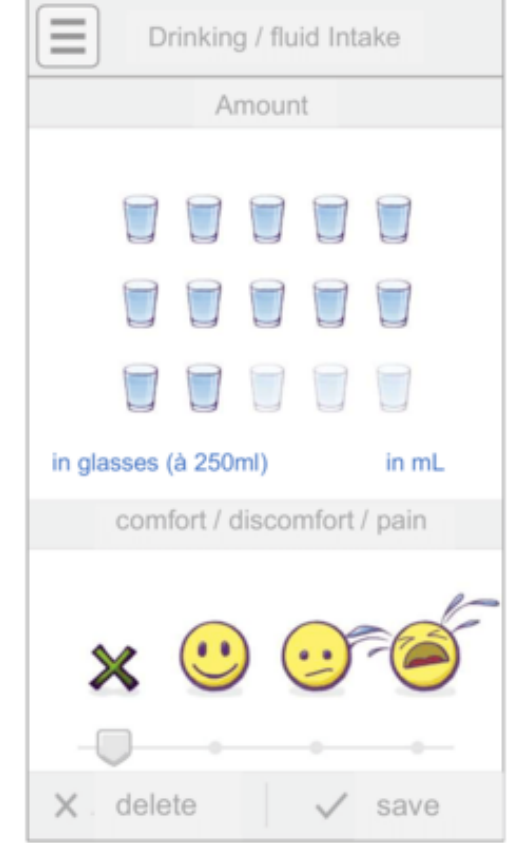
Figure 2. INTERACCT (Integrating Entertainment and Reaction Assessment into Child Cancer Therapy) app screenshots. A: Icons for the domains of self-reported health status—fluid and food intake (amount and difficulties); urine and stool (frequency, quality, and pain); physical exercise and play (duration in minutes); nausea and vomiting (frequency); fatigue (frequency); mouth complaints (frequency, quality, and pain); body temperature; and skin complaints (localization, frequency, and quality). B: Input for amount of fluid intake and difficulties, as an